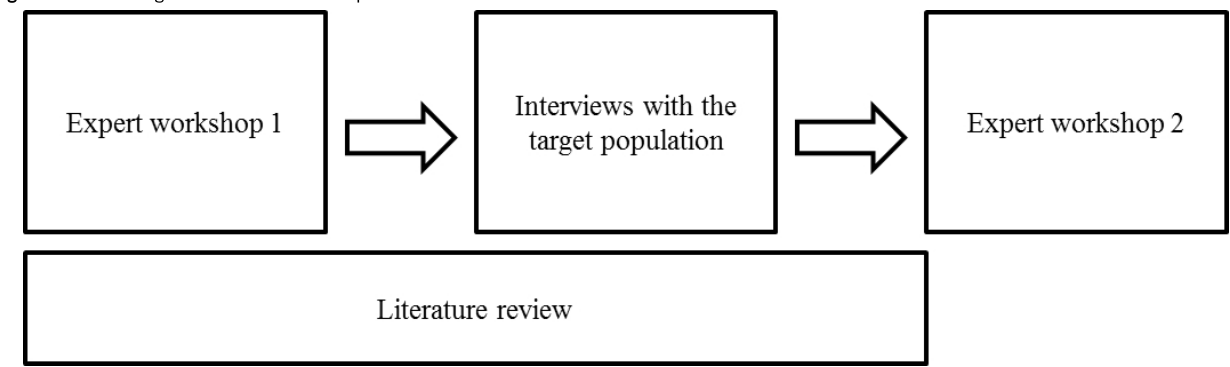
Figure 1. Flow diagram of data collection processes.